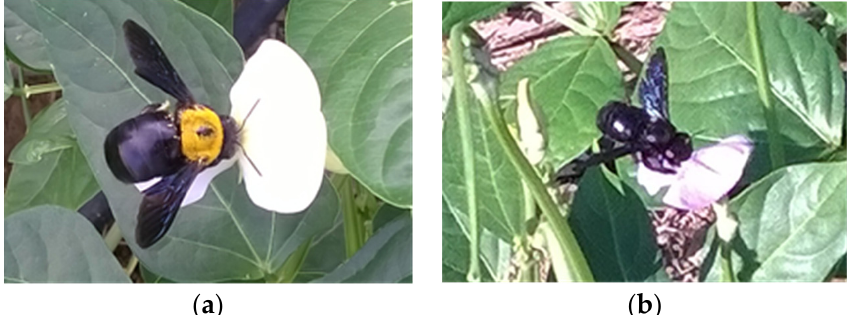
Figure 4. ( a ) Xylocopa pubescens foraging in cowpea flower of VG2; ( b ) Xylocopa valga foraging in cowpea flower of BGE038478.